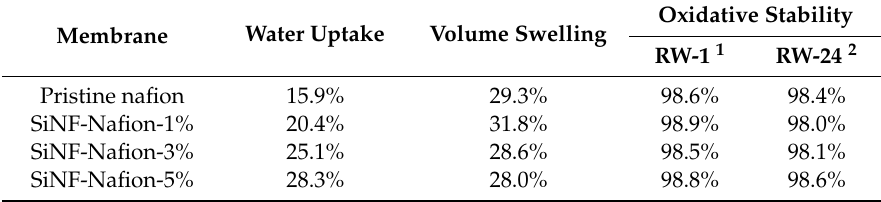
Figure 3. Stress-strain curves ( a ) and thermogravimetric (TG) curves ( b ) of the pristine Nafion and SiNF-Nafion membranes. Table 1. Water uptake, volume swelling, and oxidative stability of the pristine Nafion and SiNF-Nafion membranes.